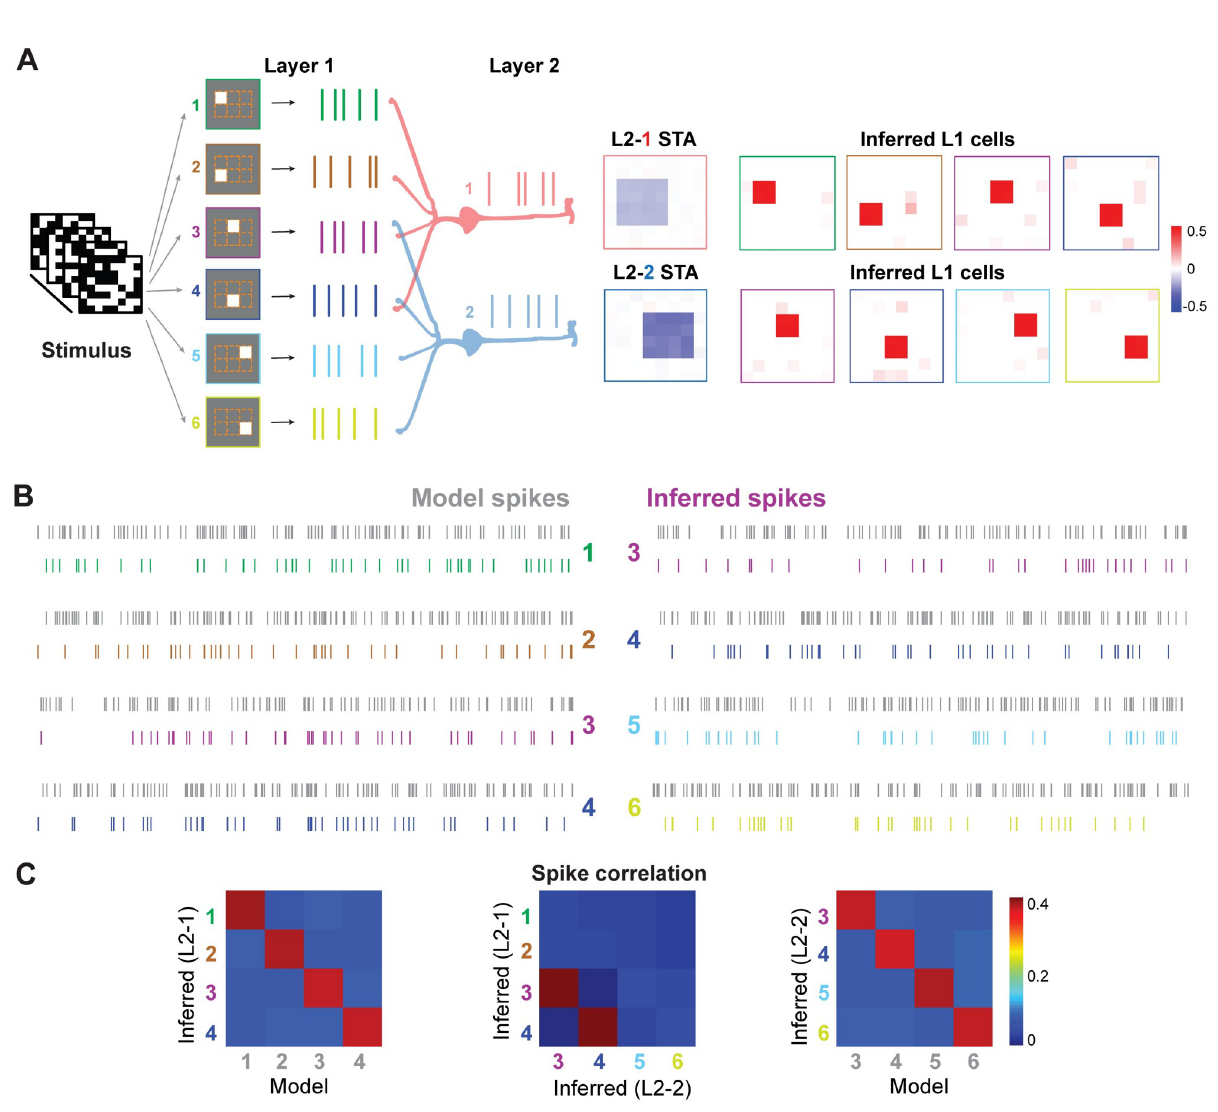
Fig 2. STNMF inference of shared presynaptic cells from different outputs of postsynaptic cells. (A) (Left) Illustration of a 2-layer network with two output neurons. Layer 1 (L1) has six cells, where the cell 3 & 4 target to both cells in layer 2 (L2). (Right) Inferred presynaptic cells independently from both cells (L2–1 and L2–2) of layer 2. Receptive fields computed by STA for cell L2–1 and L2–2 and inferred L1 cells. (B) Spike trains generated from layer 1 model cells (gray) and inferred by STNMF (colored). (C) Correlation matrices of spike trains for each cell of layer 1 computed between model cells and inferred spikes from L2–1 cell (left) and L2–2 cell (right), as well as between inferred spikes